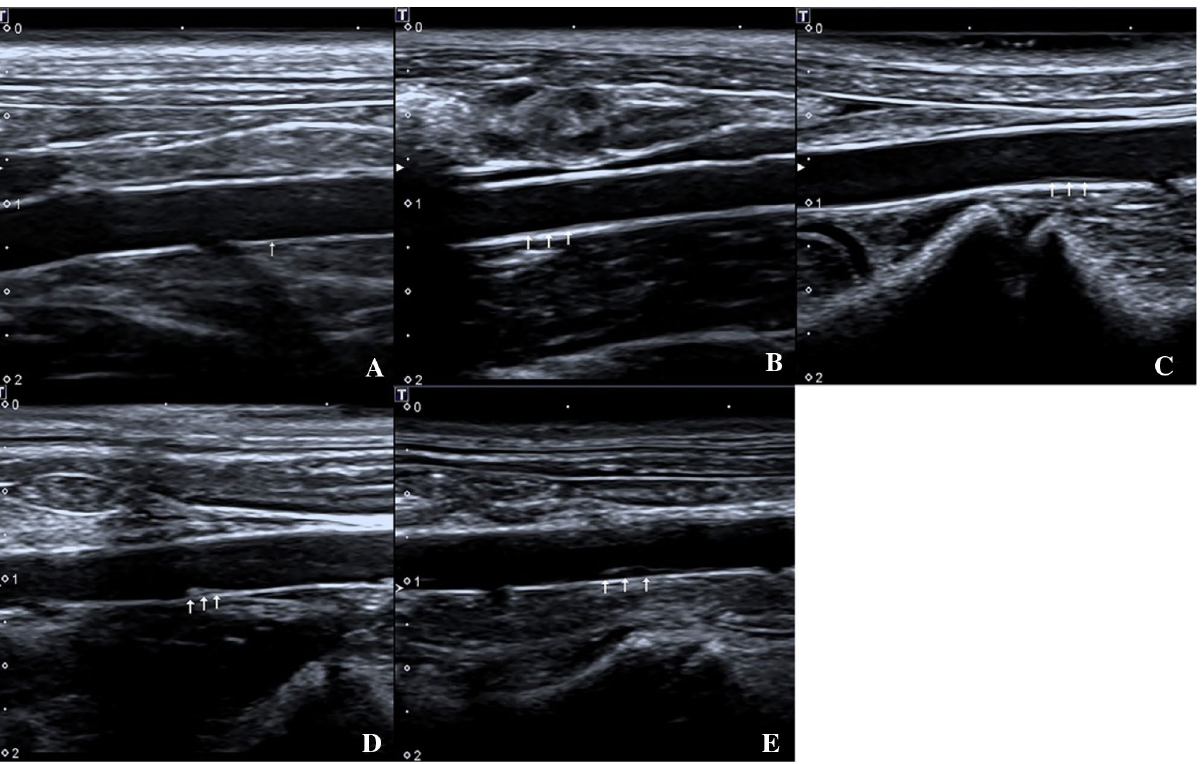
16 group. The intima-media membrane and the plaque on the wall was indicated by the